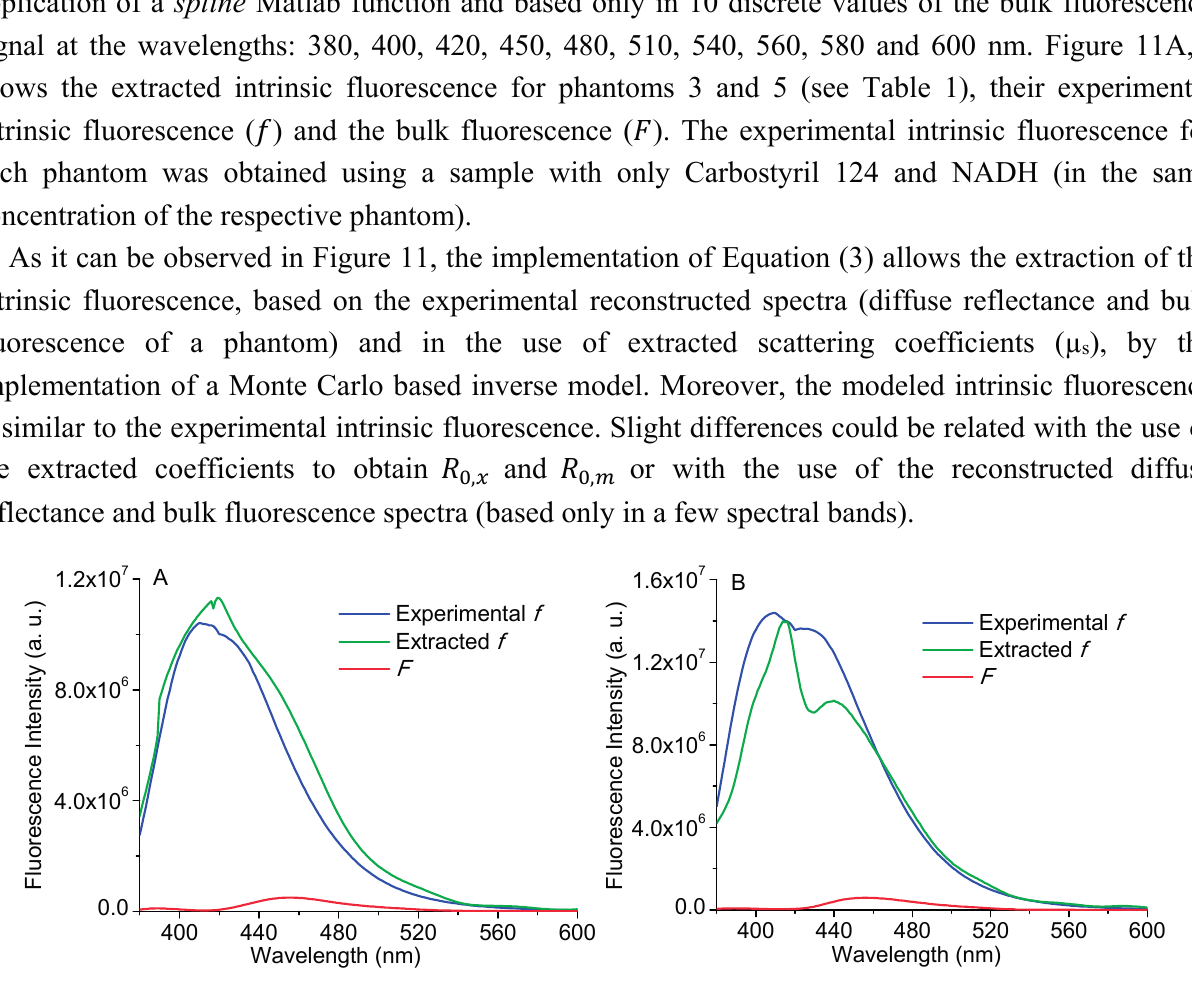
Figure 11. ( A ) Experimental and extracted intrinsic fluorescence ( (cid:1858) ) and bulk fluorescence ( (cid:1832) ) for phantom 3; ( B ) Experimental and extracted intrinsic fluorescence ( (cid:1858) ) and bulk fluorescence ( (cid:1832) ) for phantom